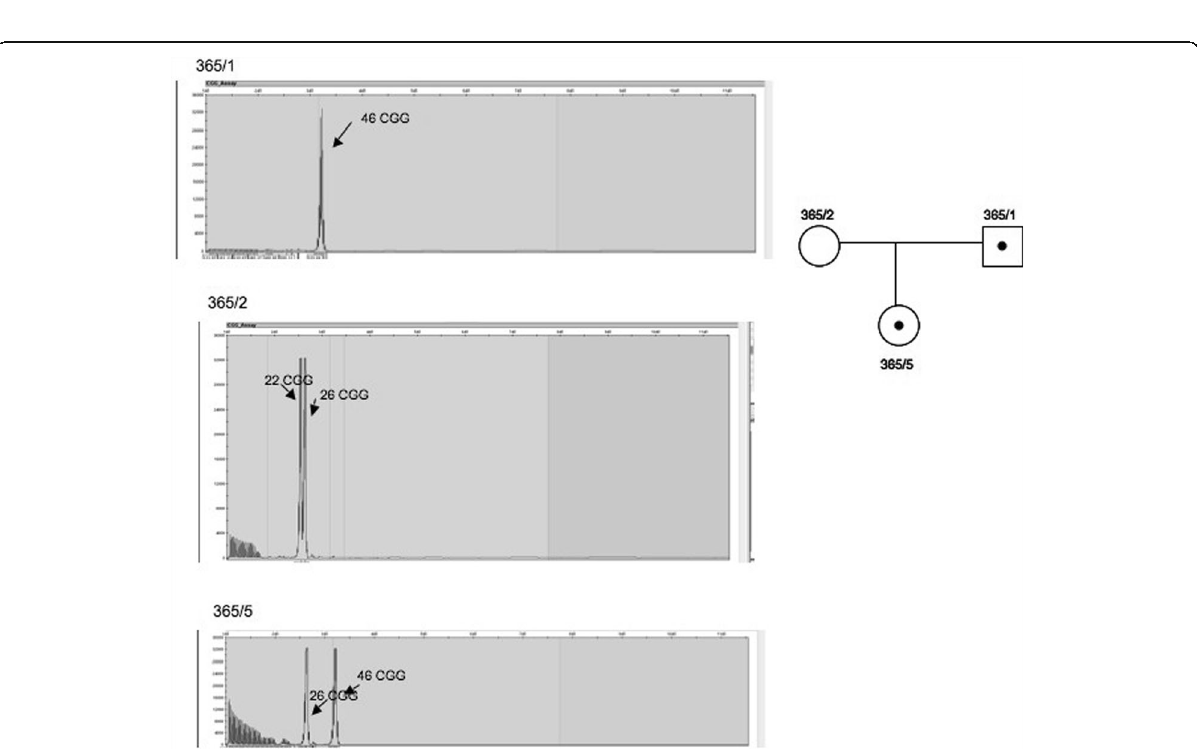
Fig. 2 Inheritance of the paternal allele within the gray zone. The figure shows family No. 9 (code 365), the father (365/1) carries a 46 CGG repeat within the gray zone, the mother (365/2) carries the normal 22 and 26 CGG, and their daughter (365/5) carries the 26 and 46 CGG